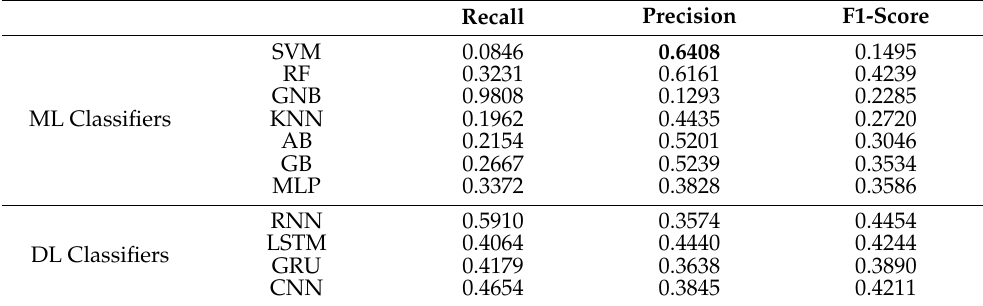
Table A3. Test results for all the classification methods evaluated, considering a time prediction horizon of +10